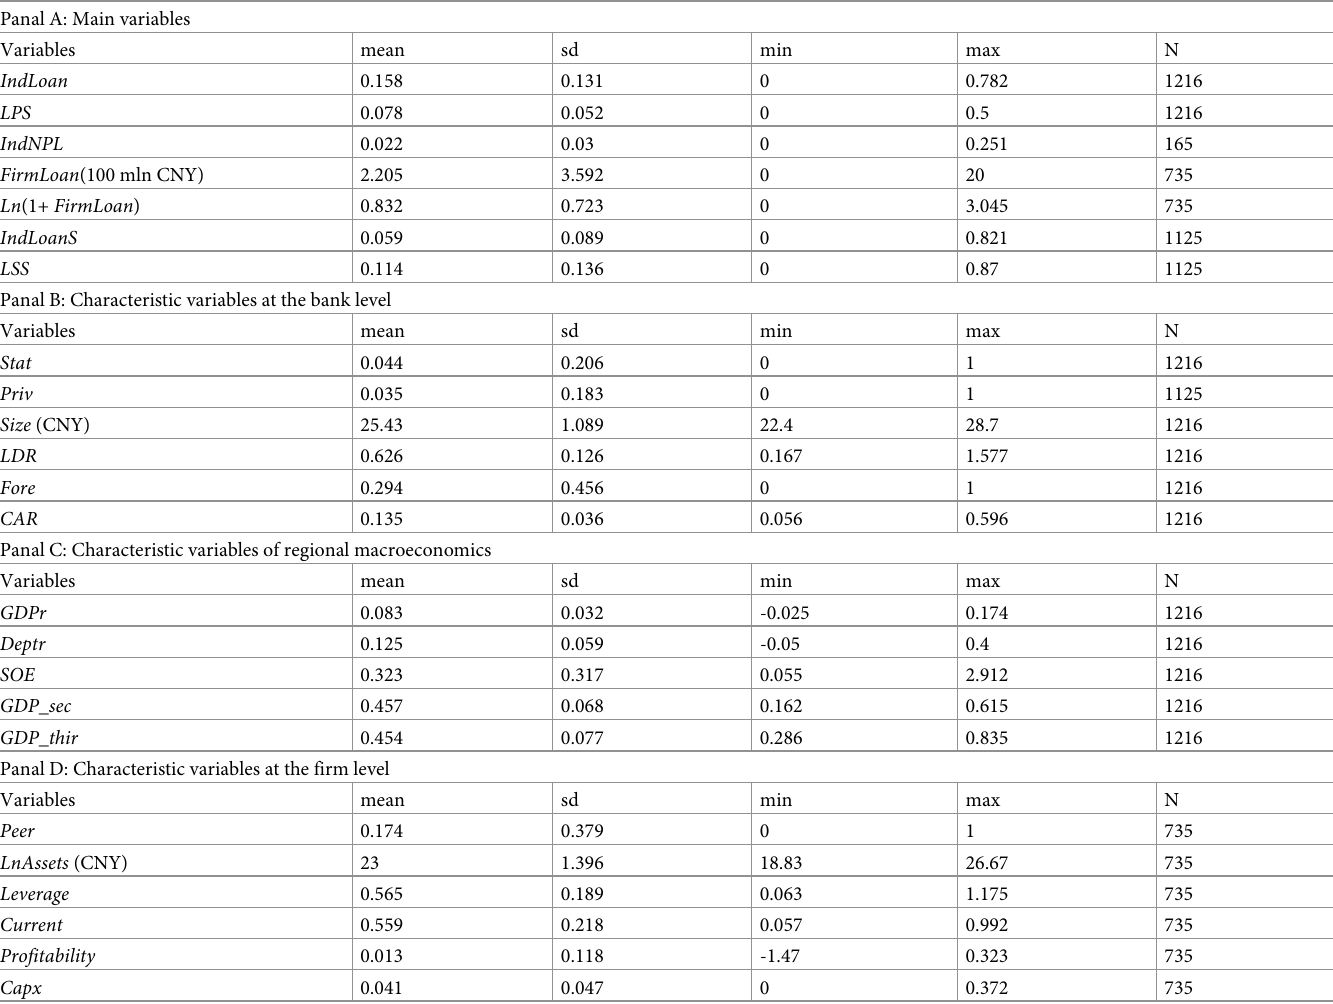
Table 1. Summary statistics. This table reports the summary statistics. Regression variables are defined in S1 Appendix. The sample period is from 2007 to